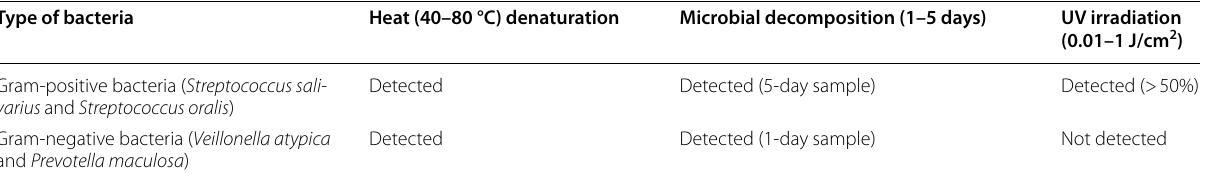
Table 4 Efficacy of oral gram-positive and gram-negative bacteria for DNA-based identification Type of bacteria